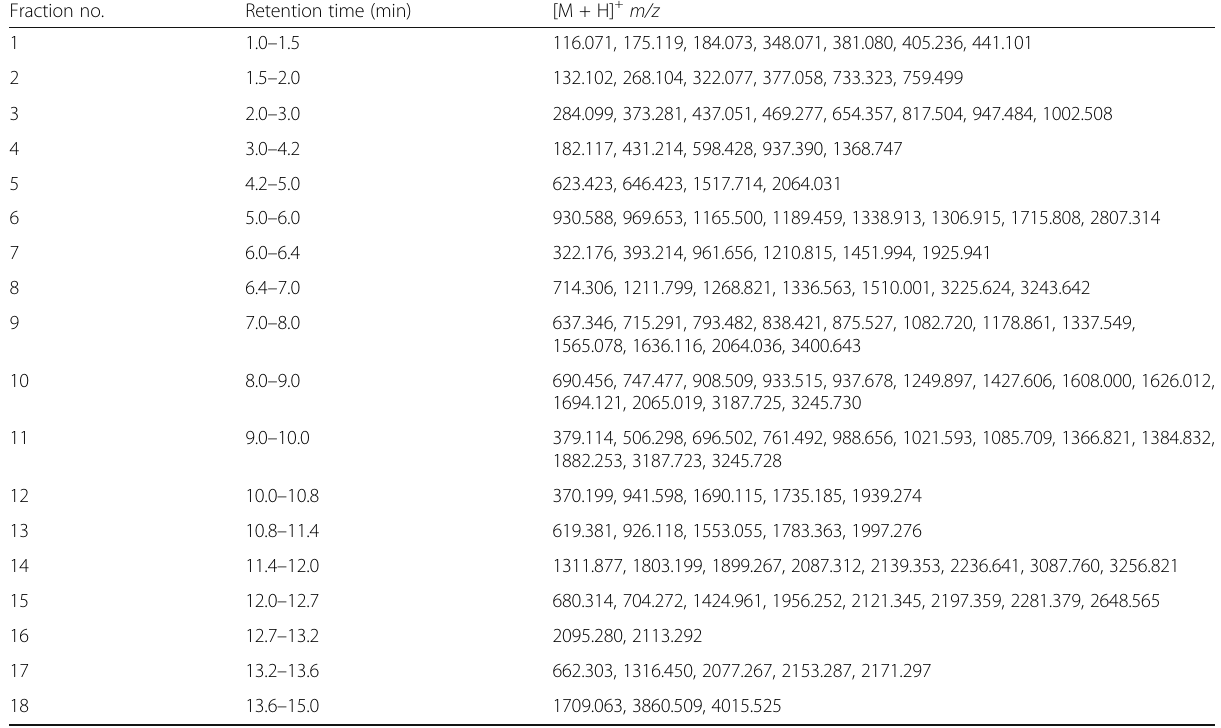
Table 2 Mass fingerprint of crude venom from X. appendiculata circumvolans Fraction